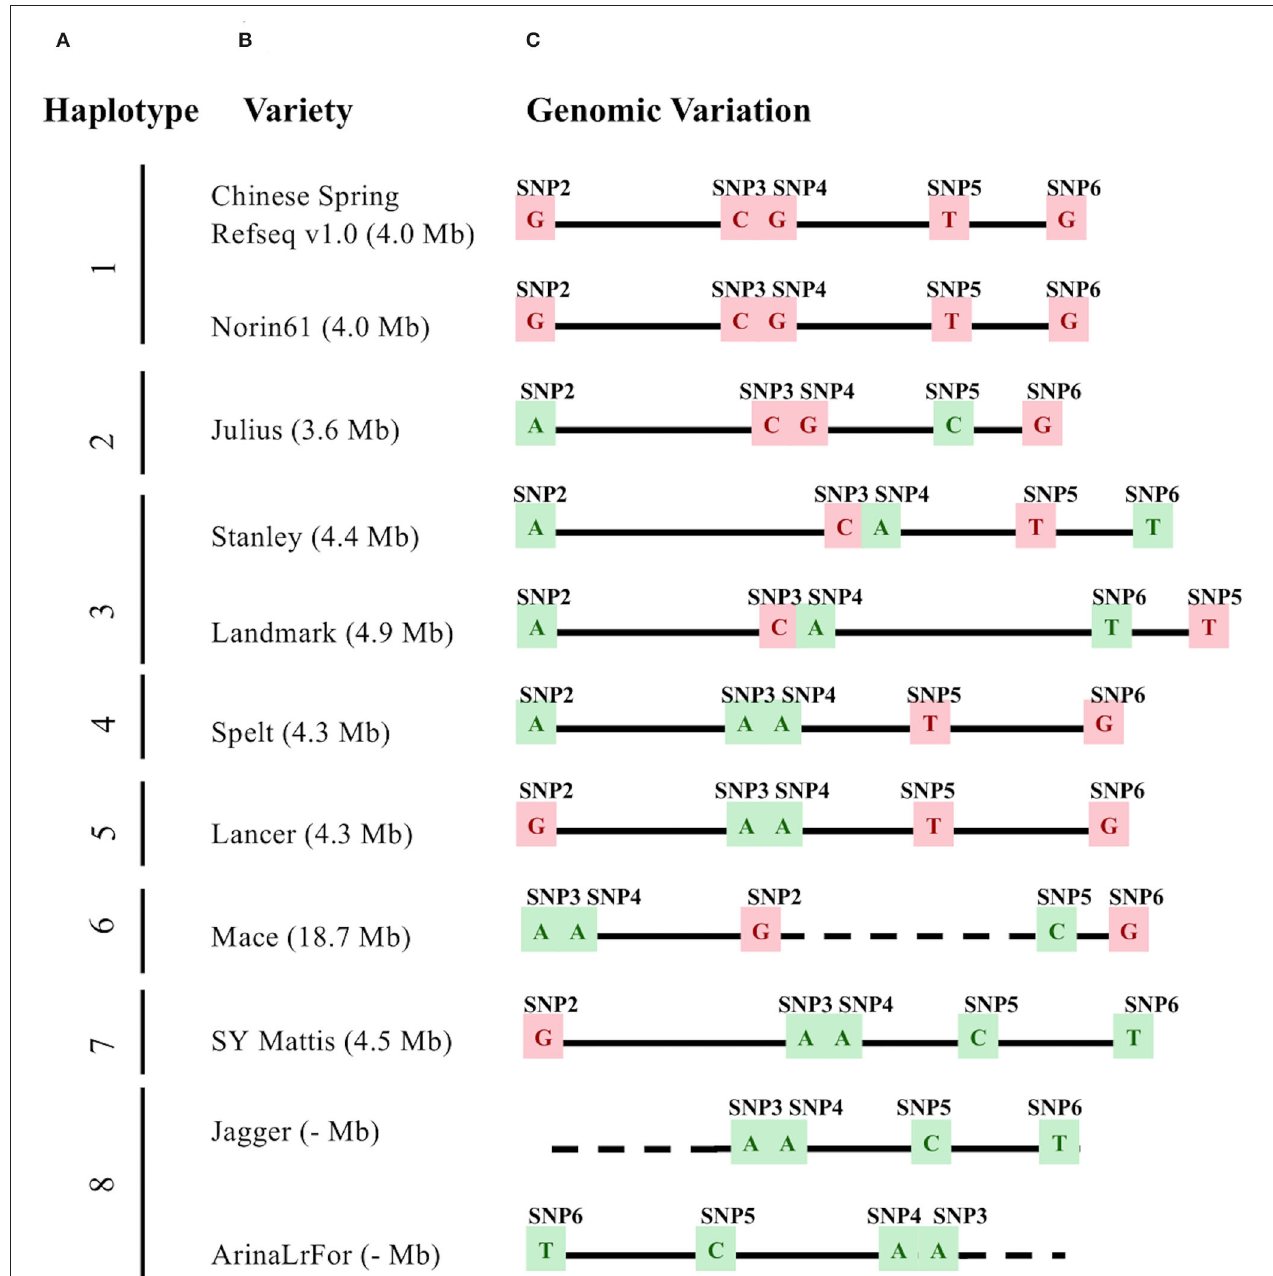
FIGURE 1 | Genomic variation underlying Wsm2 in eleven wheat varieties. (A) Haplotypes were grouped based on allele type across five single nucleotide polymorphism (SNP) markers (SNP2-SNP6). (B) Variety names and the Wsm2 interval size. (C) Haplotype and genomic position based on SNP2-SNP6. The relative physical position of markers was drawn to scale (1cm = 1 Mbp). SNPs with Wsm2 resistant allele type are highlighted in green and Wsm2 susceptible allele type in pink. Dashed lines indicate that the region is not drawn to scale because of the large insertion between SNP2 and SNP5 in “Mace,” or a deletion near SNP2 in “Jagger” and “ArinaLrFor.” The Wsm2 interval in “Jagger” and “ArinaLrFor” is indicated with a dash due to a deletion near SNP2 in these two varieties.